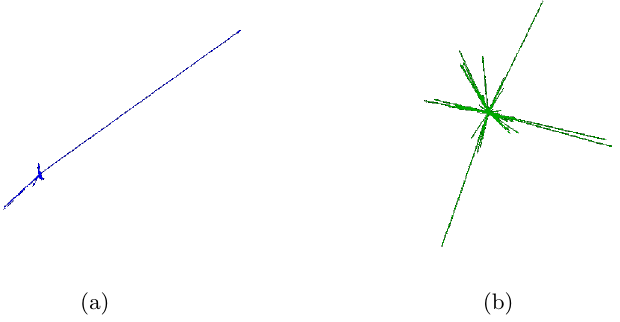
p Figure 5 . Examples of e + e (cid:0) collisions at s = 350 GeV yielding (a) a q (cid:22) q event plus a hard ISR photon and (b) a t (cid:22) t event. The events are shown in momentum space, and the magnitude of each vector is proportional to the energy of the corresponding